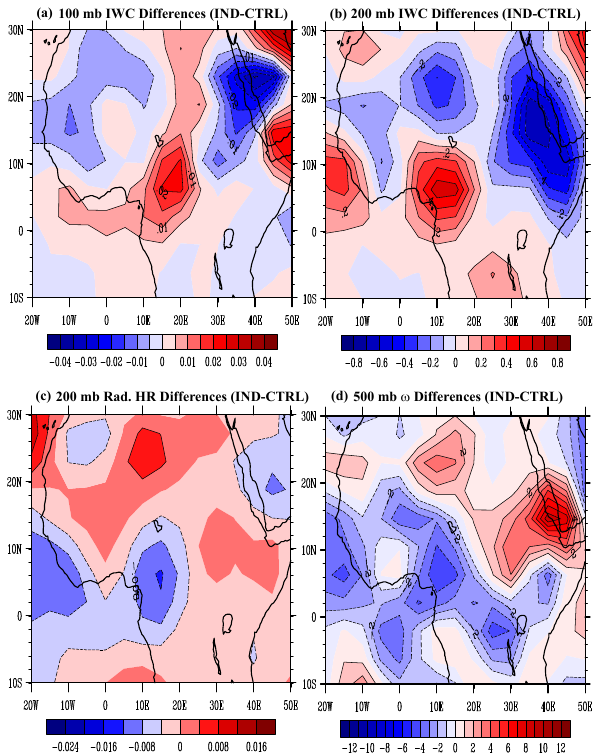
Fig. 6 Fig. 6. JJA differences in (a) 100mb and (b) 200mb IWC (mgm − 3 ) , (c) 200 mb radiative heating rate (K day − 1 ) , and (d) 500 mb ω (mb day − 1 ) between experiments IND and